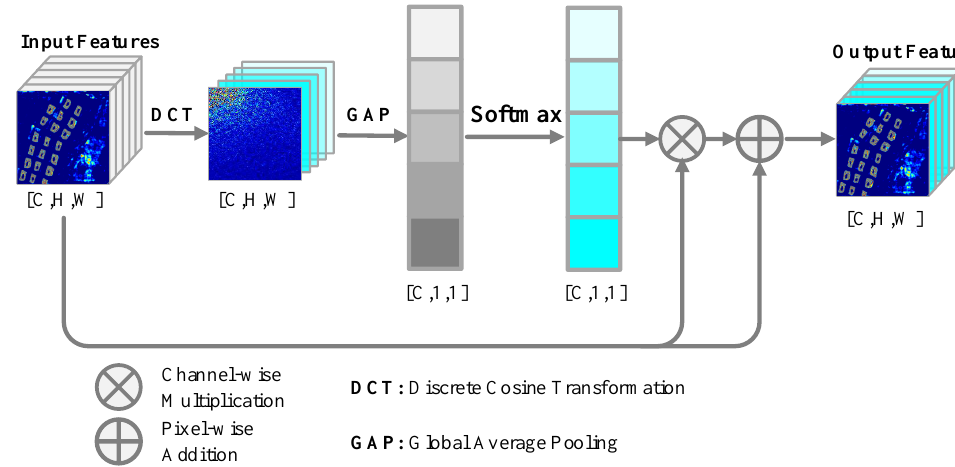
Figure 2. The procedure of